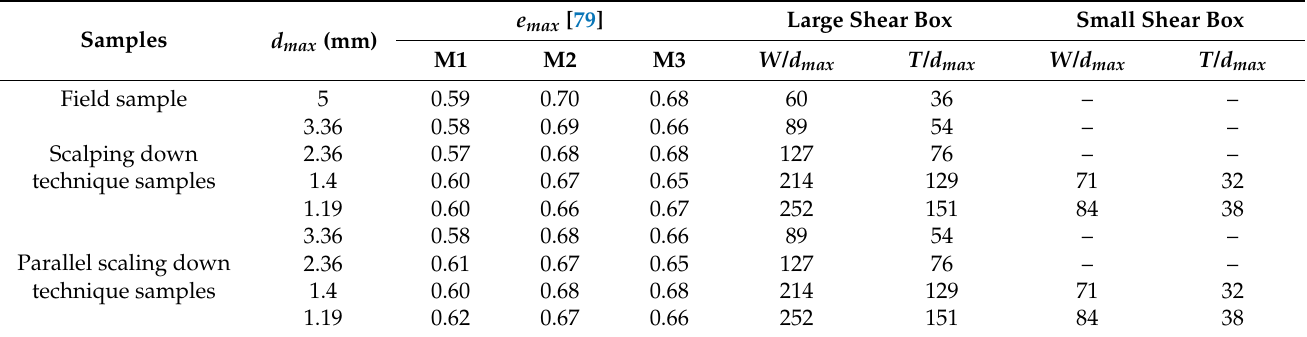
Table 3. Tested specimens along with sizes to d max ratios and e max for M1, M2 and